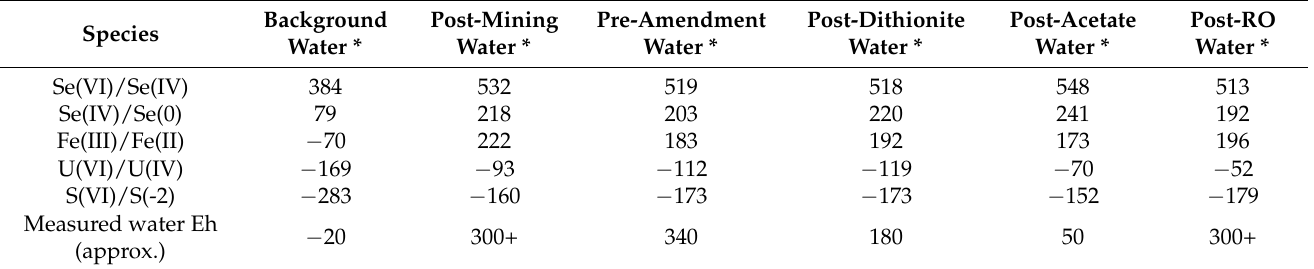
Table A11. Calculated Eh values at which oxidized and reduced species have equal concentrations from ORP measurements with the Ag/AgCl electrode) is listed in the last